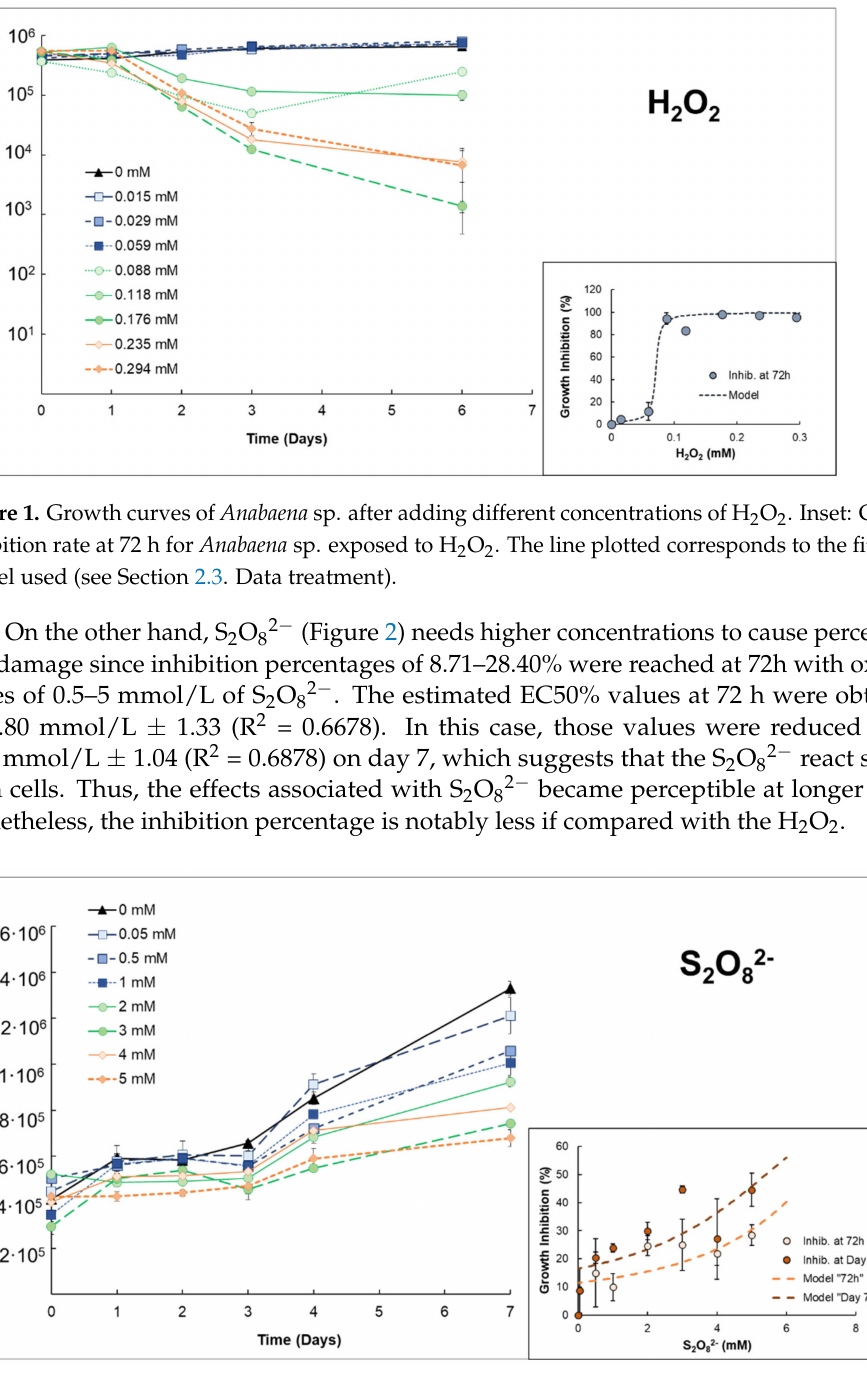
Figure 2. Growth curves of Anabaena sp. after adding different concentrations of S 2 O 8 2 − (PDS). Inset: Growth inhibition rate for Anabaena sp. exposed to S 2 O 8 2 − on specific days 3 and 7. The plotted line corresponds to the fit of the model that was used (see Section 2.3. Data